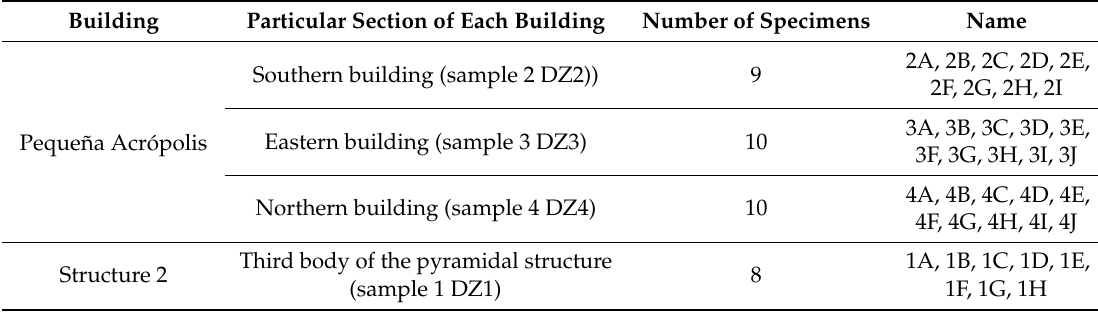
Table 1. Samples and their location for archaeomagnetism dating. The specimens in red are the ones that produced adequate measurements for the dating process.